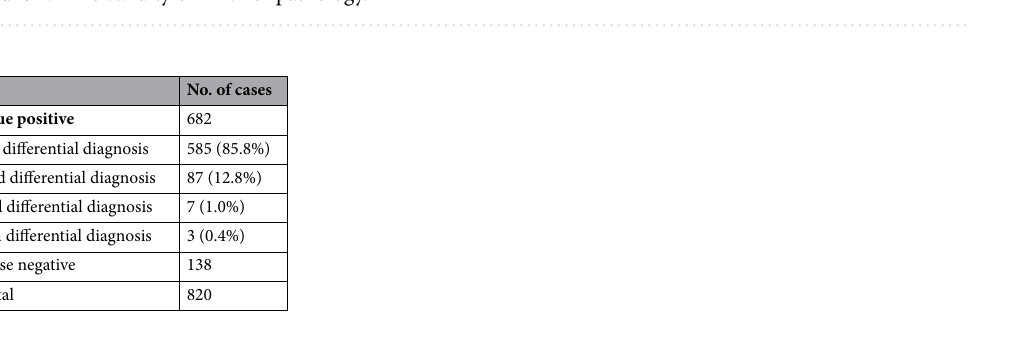
Table 3. Consistency of MRI and pathology in each differential